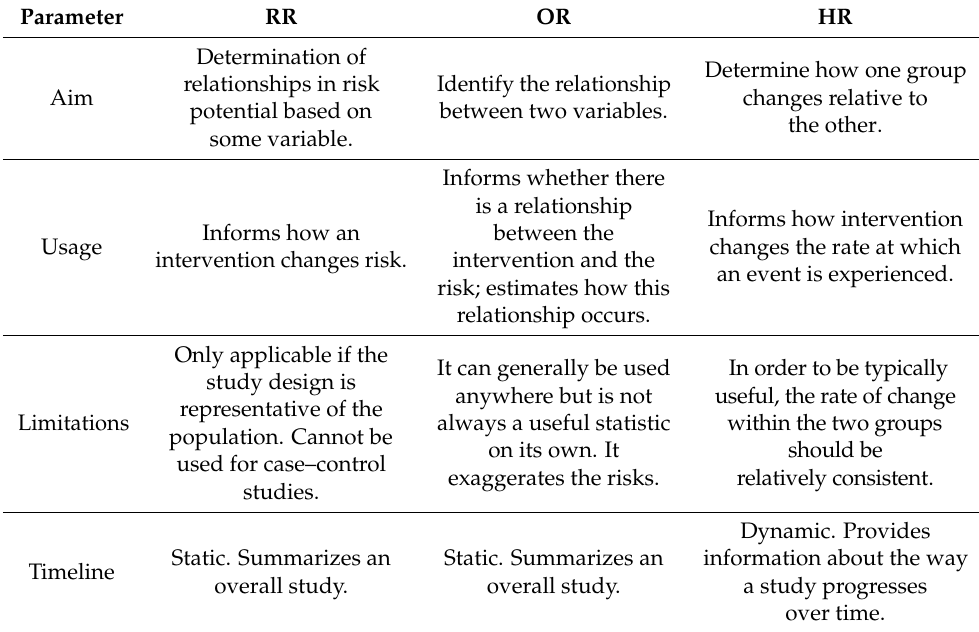
Table 2. Risk ratio (RR) vs. odds ratio (OR) vs. hazard ratio (HR) [36].